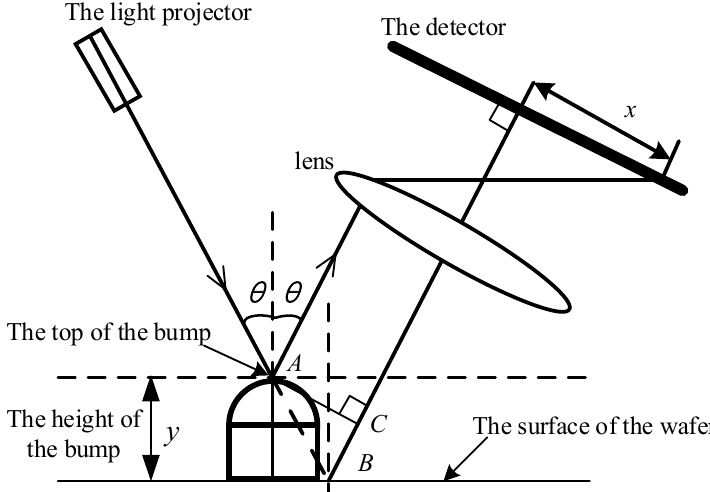
Figure 2. The main structure and the material composition of a typical bump.